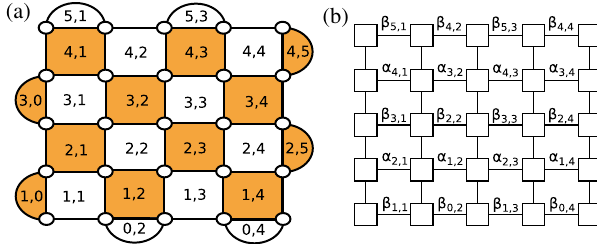
FIG. 15. (a) Check coordinates are assigned to each check in the rotated layout. (b) The tensor network is defined such that each horizontal edge corresponds to a specific check. The α indices correspond to X checks, and the β indices correspond to Z checks, with the subscripts indicating the check coordinates. Each tensor corresponds to a specific qubit. The bond dimension of horizontal edges is 2, while the bond dimension of the vertical edges is